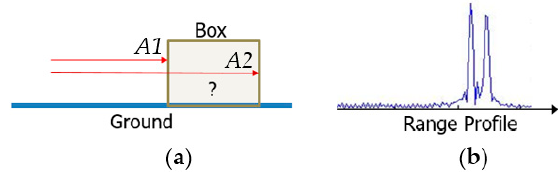
Figure 1. ( a ) Problem setup, and ( b ) expected range profile.